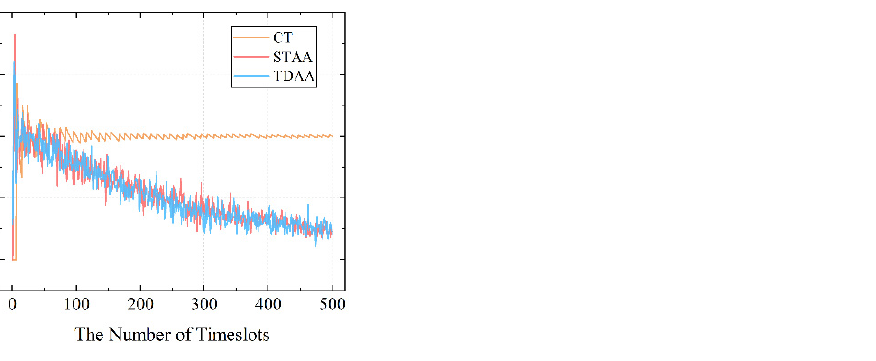
Figure 5. Schematic diagram comparing the CRJ between continuous transmission (CT), the TDAA [11], and the STAA.